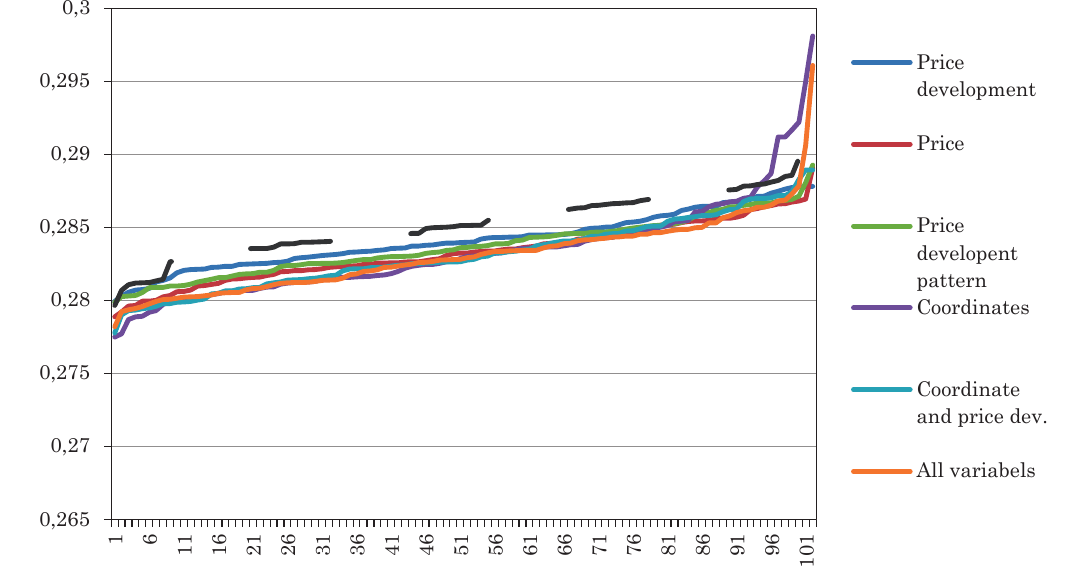
Figure 5. Variation of RMSE between the replications for the clustering